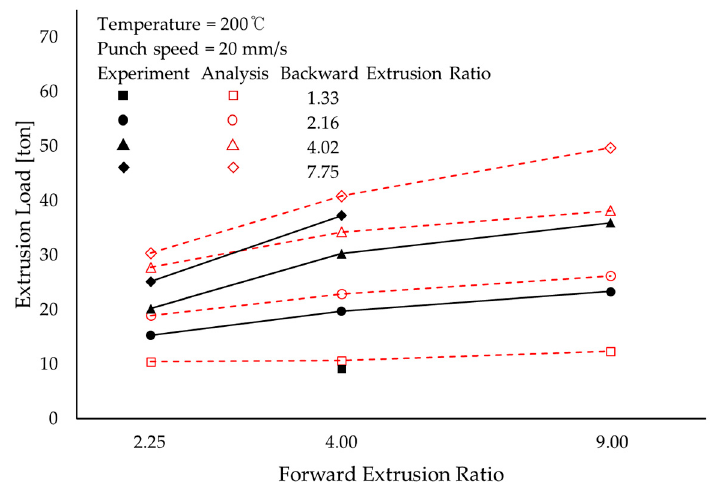
Figure 8. Extrusion loads for various forward–backward extrusion ratios.